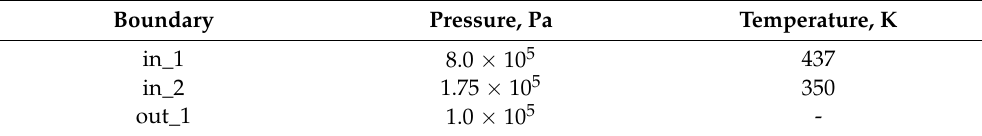
Table 3. The boundary